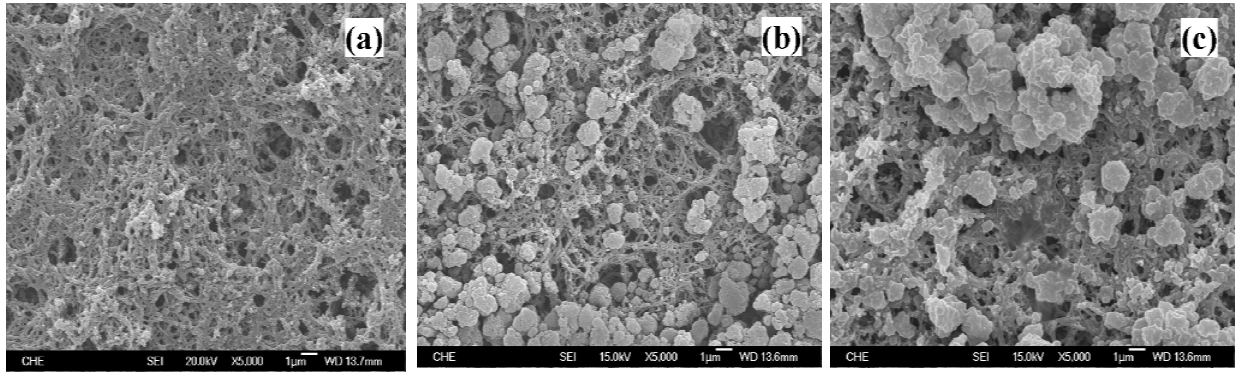
Figure 4. The SEM images of the surfaces of (a) PANI/Pt, (b) SBA-15/PANI/Pt, and (c) GA/SBA-15(HRP)/PANI/Pt